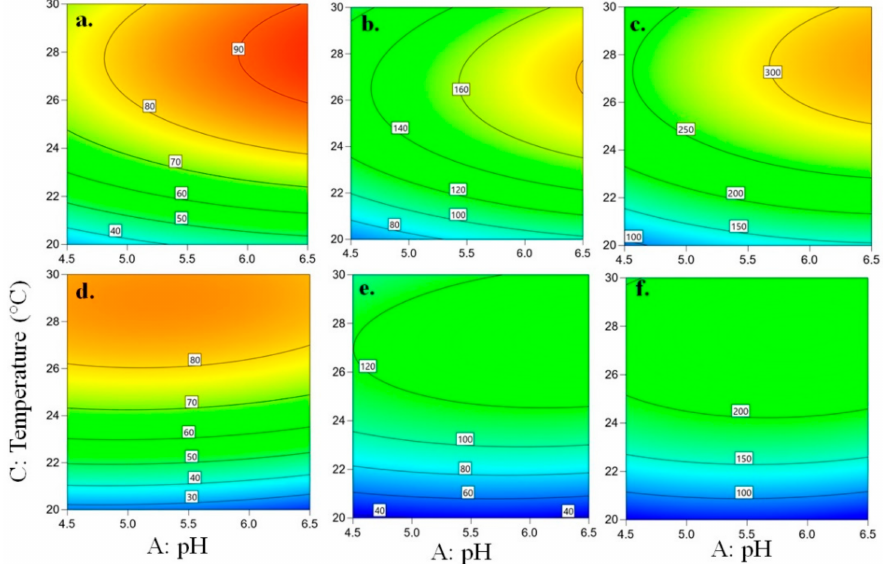
Figure 6. Effect of temperature and pH during the fermentation of hydrolysates produced under hydrothermal conditions to produce ( a ) 1-propanol (mg/L), ( b ) 2-methyl-1-propanol (mg/L), and ( c ) 3-methyl-1-butanol (mg/L), and under acid hydrolysis conditions to produce ( d ) 1-propanol (mg/L), ( e ) 2-methyl-1-propanol (mg/L), and ( f ) 3-methyl-1-butanol (mg/L). Stirring = 100 rpm, fermentation time = 24